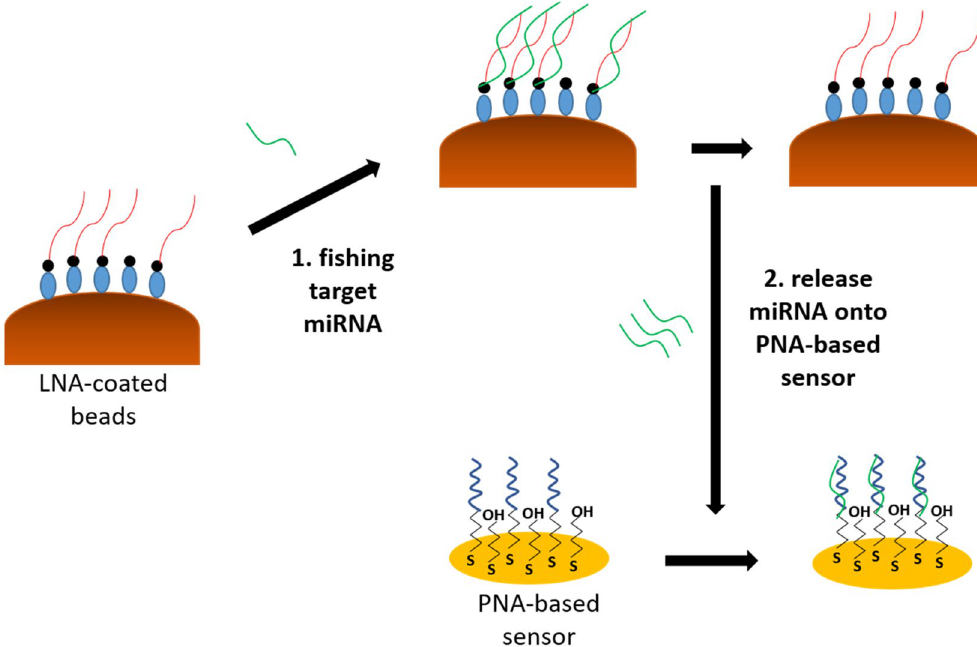
Figure 1. Schematic diagram of the assay: (1) LNA-coated magnetic beads capture target miRNAs from sample; (2) release of the capture miRNA from magnetic beads which are re-hybridized with PNA-probe for electrochemical detection .